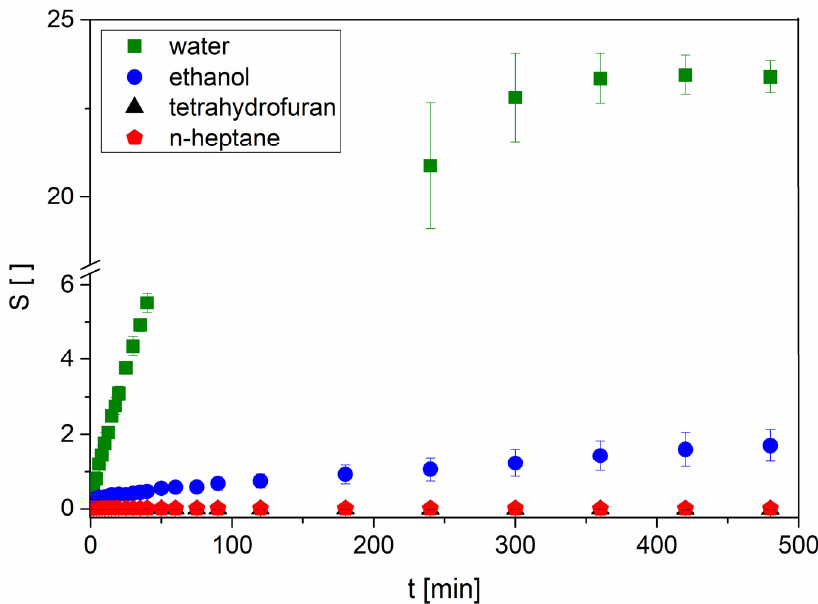
Figure 3. Swelling kinetics of poly(VEImBr) in different solvents (30 ± 1 °C; n = 3; MBAA: 2